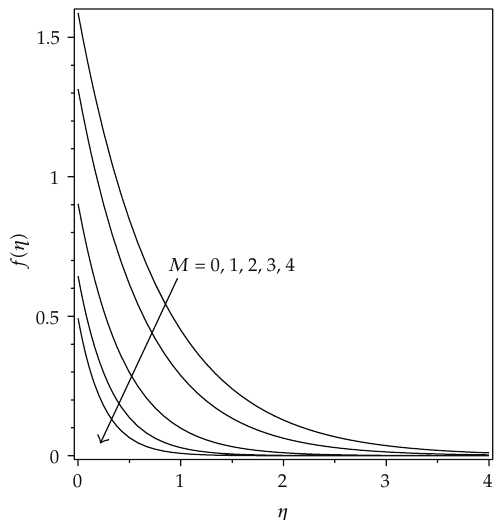
Figure 1: Velocity profiles for di ff erent values of M when Pr (cid:9) 0 . 78, Sc (cid:9) 0 . 6, D f (cid:9) 0 . 03, S r (cid:9) 2, r (cid:9) 0, and f (cid:9) 0. 0